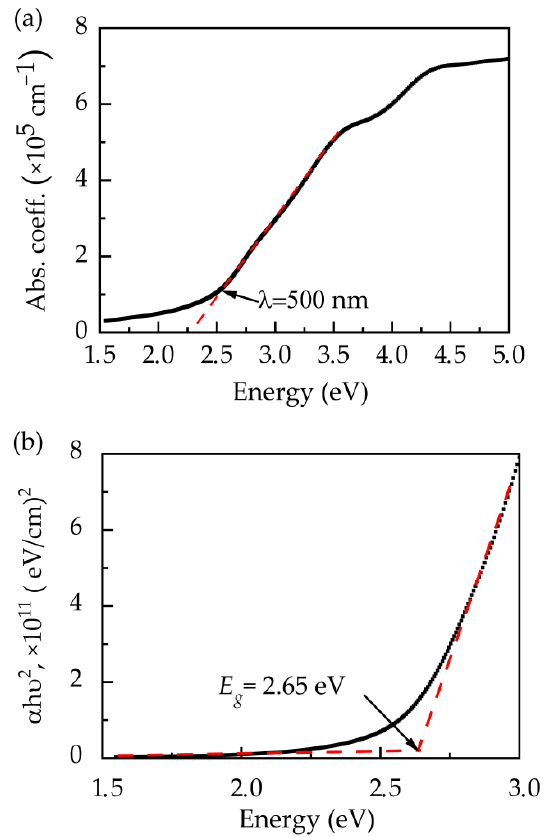
Figure 3. ( a ) Absorption coefficient α with photon energy and ( b ) Tauc’s plot of thin copper oxide film. The optical width of the band gap is estimated according to the absorption